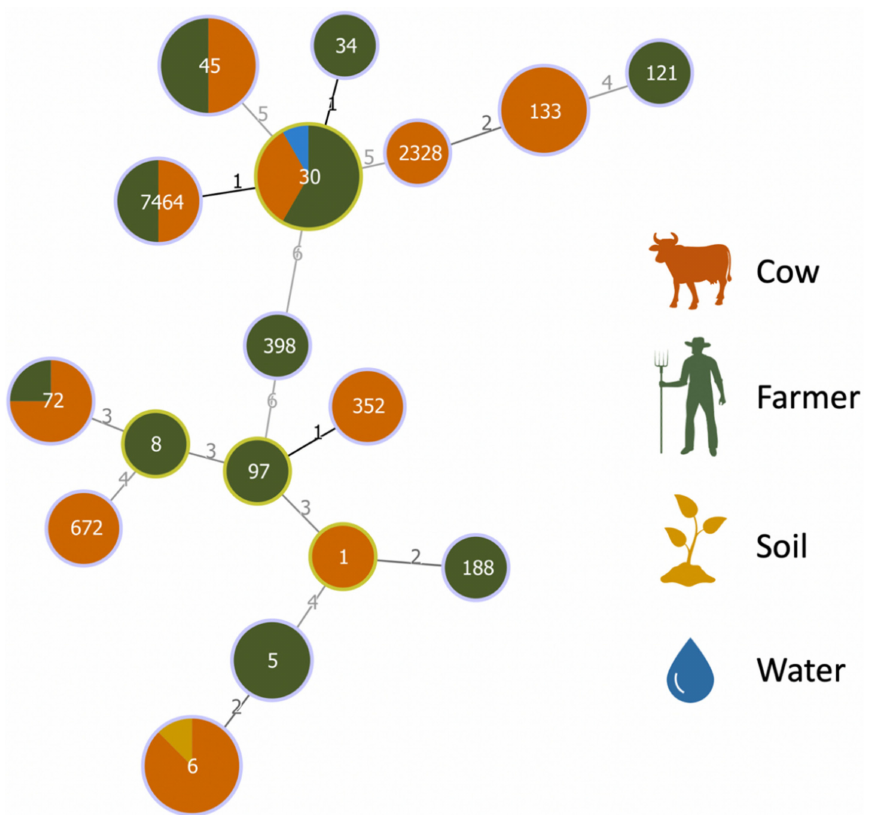
Figure 1. Minimum spanning tree, based on MLST of 58 S. aureus isolated from farm workers, cows and their surroundings. The minimum spanning tree graph (MST) was created with PHYLOViZ using the goeBURST algorithm. The dominant STs are represented by the circles with larger diameters. Each color represents one sample source. Numbers on lines indicate locus variants between adjacent